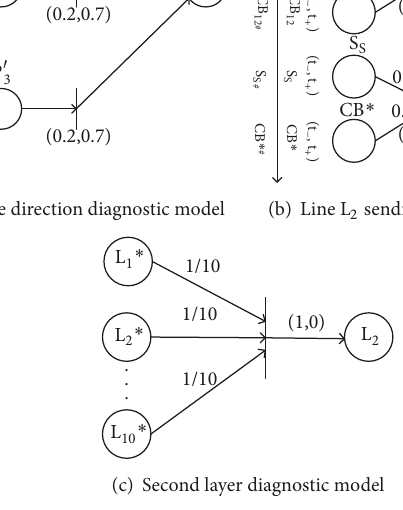
Figure 7: Line L 2 fault comprehensive diagnosis model.